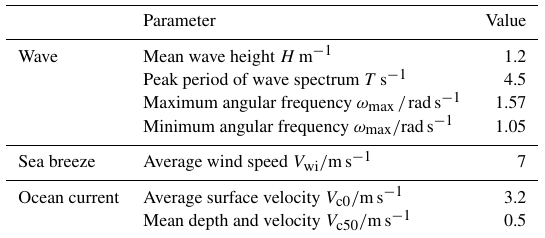
Table 1. The real service marine data in the South China Sea.